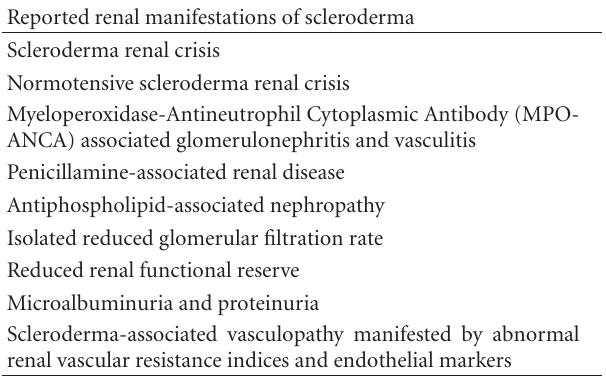
Table 1: Reported renal manifestations of scleroderma.